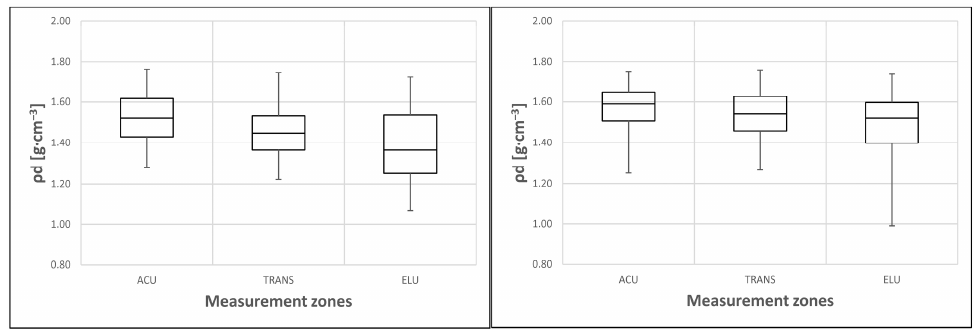
Table 1. Value of saturated hydraulic conductivity.